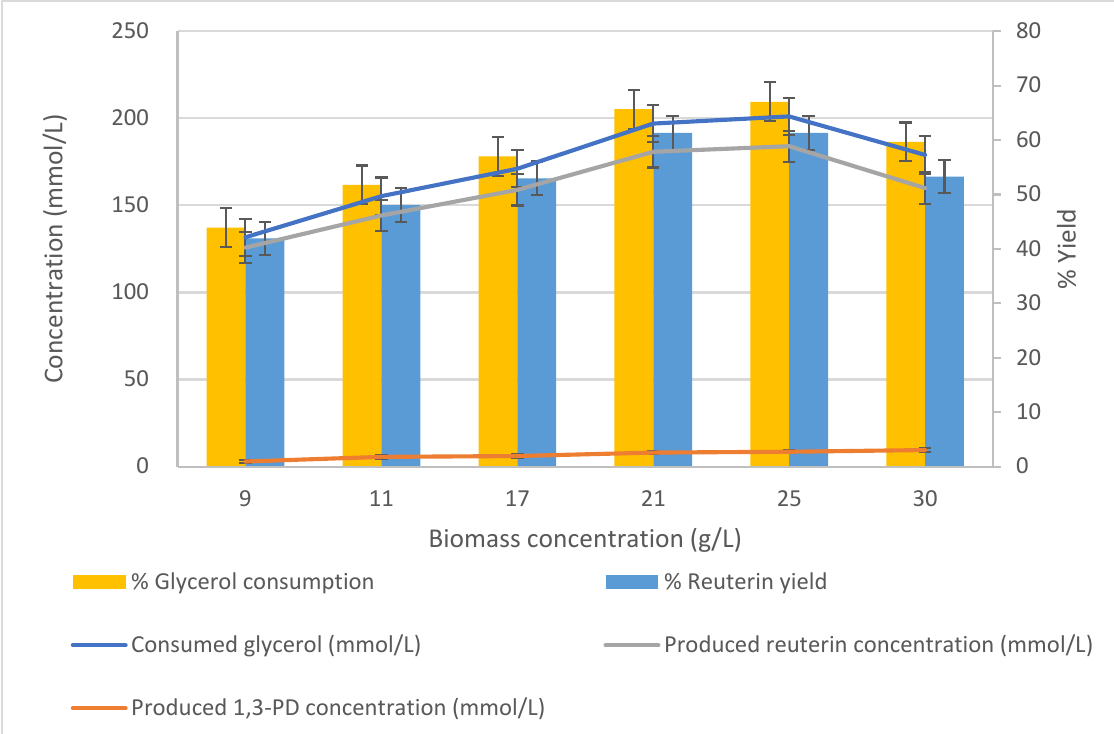
Figure 4. Effect of biomass concentration on reuterin production.